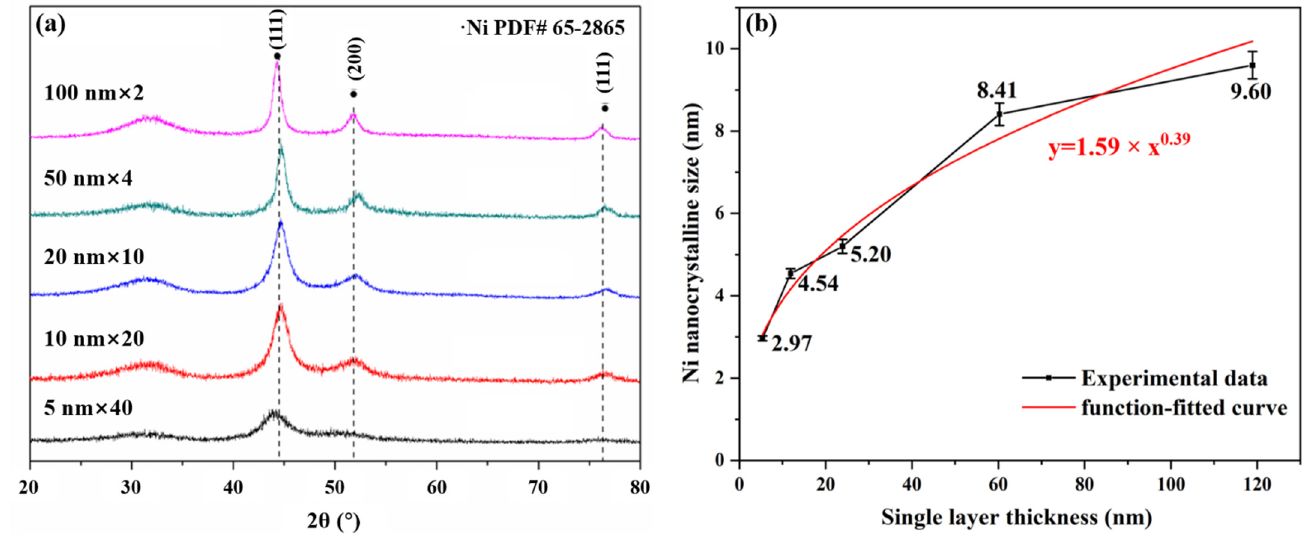
Figure 1. ( a ) The GIXRD spectra of pristine amorphous ZrC/nanocrystalline Ni multilayers. ( b ) The Ni crystalline grain size and its nonlinear fitting curve changing with layer thickness.